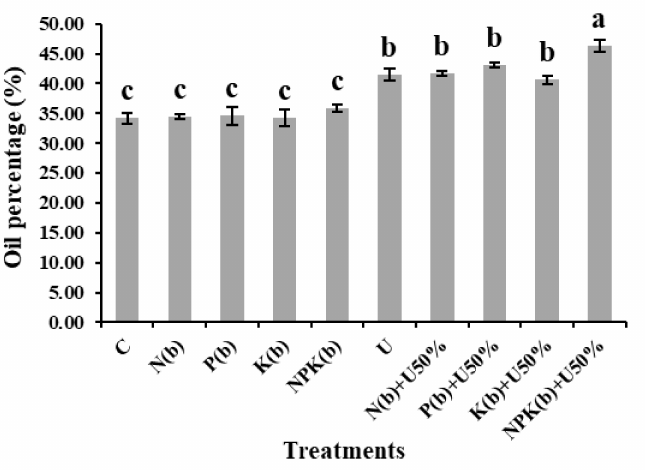
Figure 2. Means comparison for seed oil percentage of Nigella sativa L. as influenced by biofertilizers and chemical urea. Different letters indicate a significant difference according to PLSD test with 3 replications at the p ≤ 0.05. (chemical urea fertilizer (U), biofertilizer N (b) , biofertilizer P (b) , biofertilizer K (b) , mixed biofertilizer NPK (b) , 50% urea + biofertilizer N (N (b) + U 50% ), 50% urea + biofertilizer P (P (b) + U 50% ), 50% urea + biofertilizer K (K (b) + U 50% ), and 50% urea + biofertilizer NPK (NPK (b) + U 50% )).